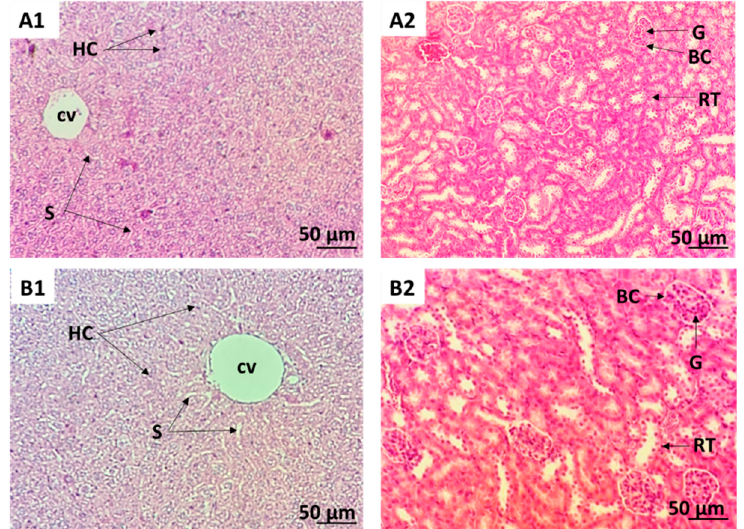
Figure 2. Photomicrograph (hematoxylin-eosin staining; ×200 magnification) of liver and kidney sections of mice after administration or not of a single oral dose of CSSE (2000 mg/kg). ( A1 ): liver section of control mice. ( B1 ): liver section of mice treated with CSSE. ( A2 ): kidney section of control